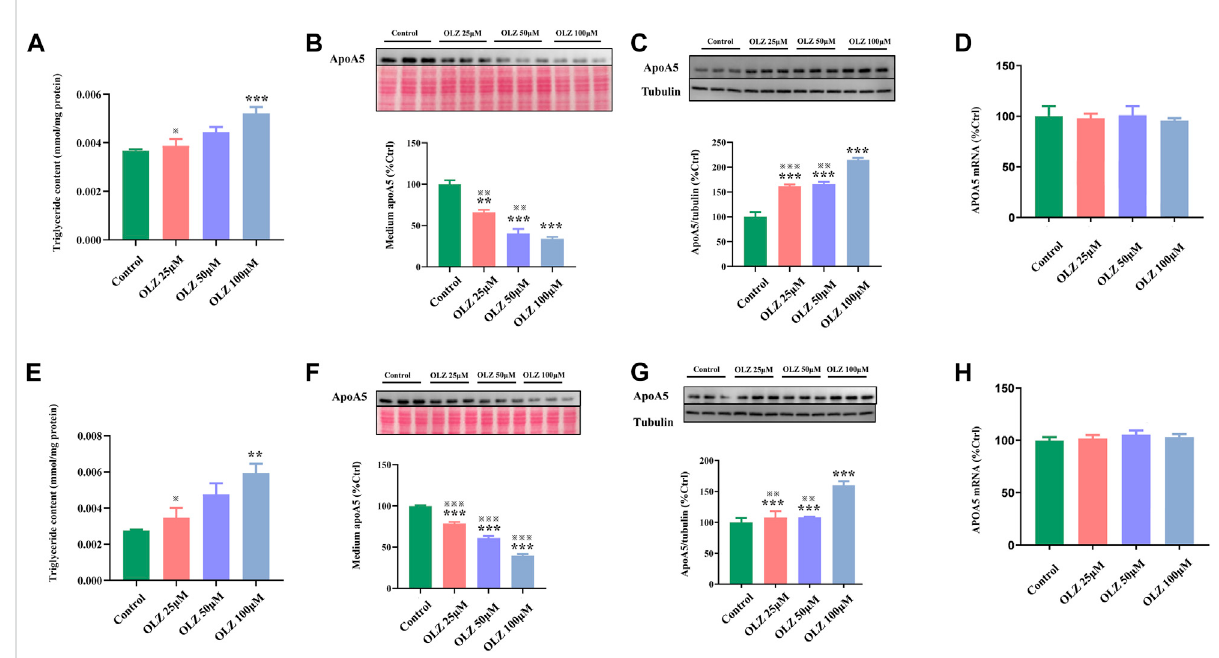
FIGURE 3 The effects of olanzapine (OLZ) on medium triglyceride levels, apoA5 protein and APOA5/apoA5 mRNA expression in human and mouse hepatocytes in vitro . Triglyceride levels of medium in human hepatocytes (A) . Intracellular apoA5 protein levels (B) , apoA5 protein levels in the medium (C) (70 μ g protein was loaded per lane and loading was con fi rmed by Ponceau-staining ) and APOA5 mRNA (D) in HepG2 cells. Triglyceride levels of medium in primary mouse hepatocytes (E) . Intracellular apoA5 protein levels (F) , apoA5 protein levels in the medium (G) (100 μ g protein was loaded per lane and loading was con fi rmed by Ponceau-staining ) and ApoA5 mRNA (H) in primary mouse hepatocytes. Data represent the mean ± SEM. * p < 0.05 vs. control, ** p < 0.01 vs. control, ※※ p < 0.01 vs. olanzapine (OLZ) 100 µM group, ※※※ p < 0.001 vs. olanzapine (OLZ) 100 µM